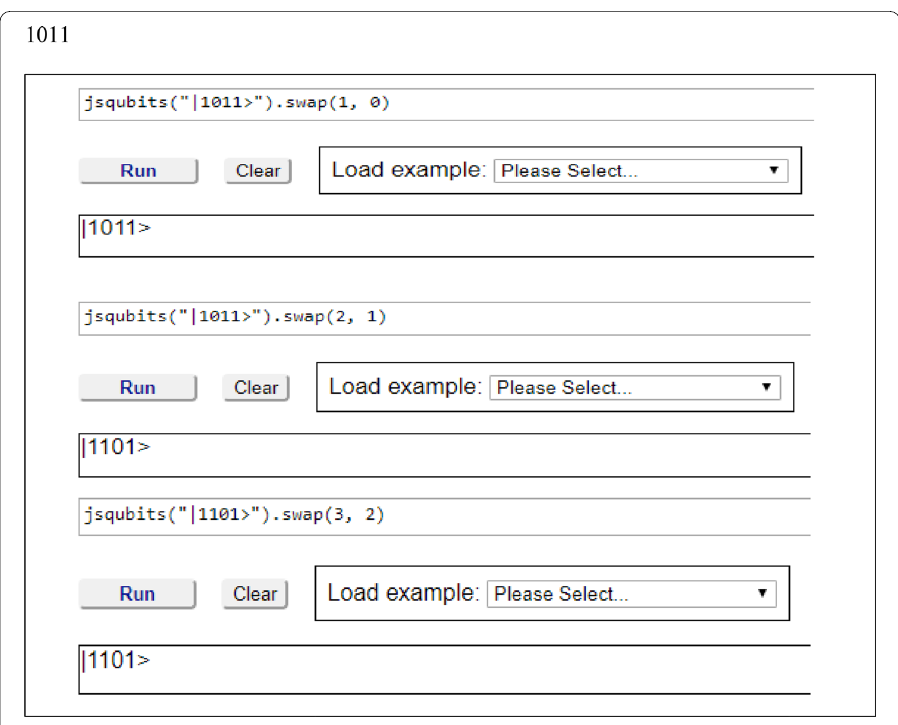
Fig. 22 Rotating quantum bit string |1011 > by using a swap